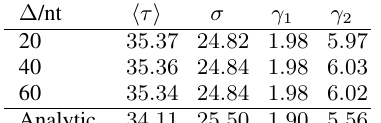
S TATISTICS FOR THE DISTRIBUTIONS AT VARIOUS VALUES OF ∆ COMPARED TO THE STATISTICS OF THE ANALYTIC DISTRIBUTION FOR THE PARAMETERS OF FIGURE